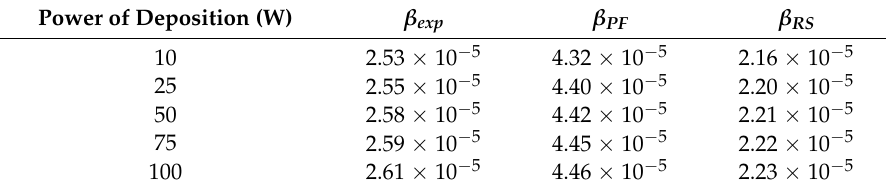
Table 2. Experimental β exp and theoretical β PF and β RS values of pelargonium plasma polymer films.